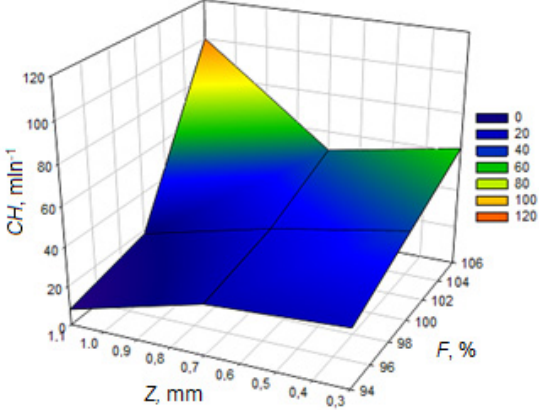
Figure 10. The dependence of the CH content on the capa– city of the electromagnetic nozzle F and the spark plug gap Z (at the resistance of the catalytic converter R = 10 mm = const and a 20% throttle opening degree) The dependence in Fig. 10 is approximated by